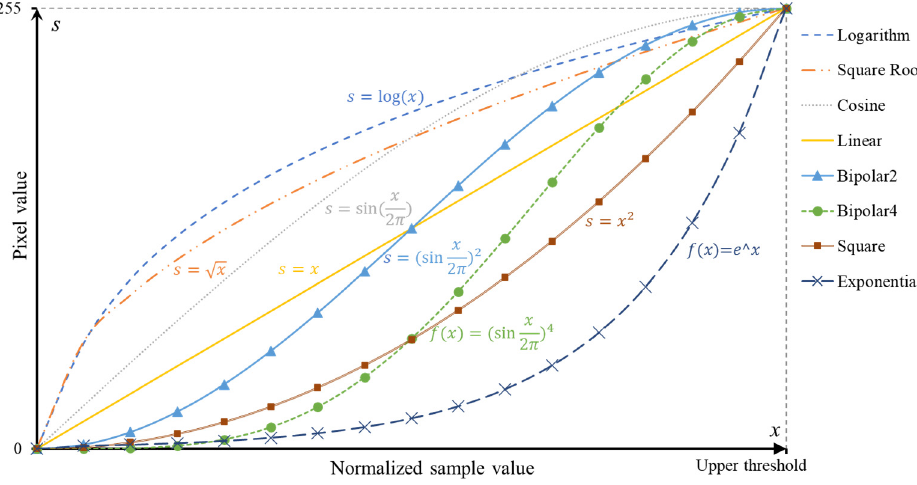
Figure 3. Illustration of different intensity transformation